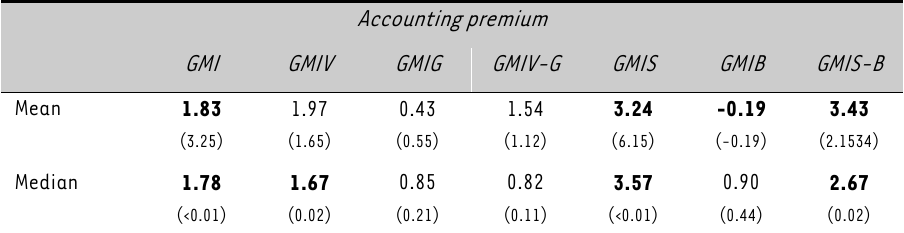
TABLE 3: Summary statistics for the accounting premium, July 2000 to June 2005 (60